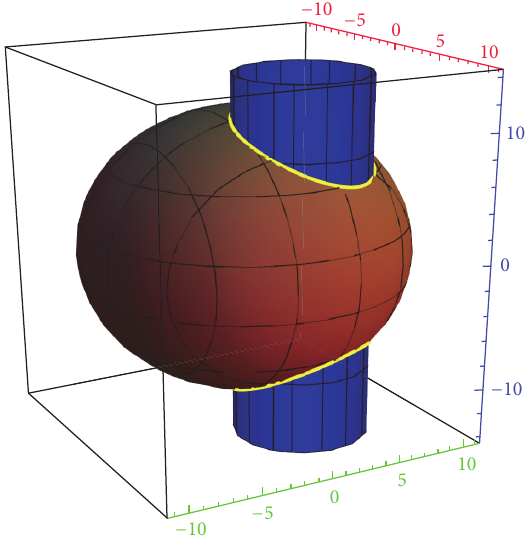
Figure 7: The fiber F (ℎ,𝑐) , (ℎ,𝑐) ∈ Σ 𝑝 1 : a pair of periodic orbit. 𝜑 = 2 arcsin ( tanh 𝑝(𝑡)) − 𝜑 𝜑 and sin 𝜑 , we 0 . Computing cos obtain